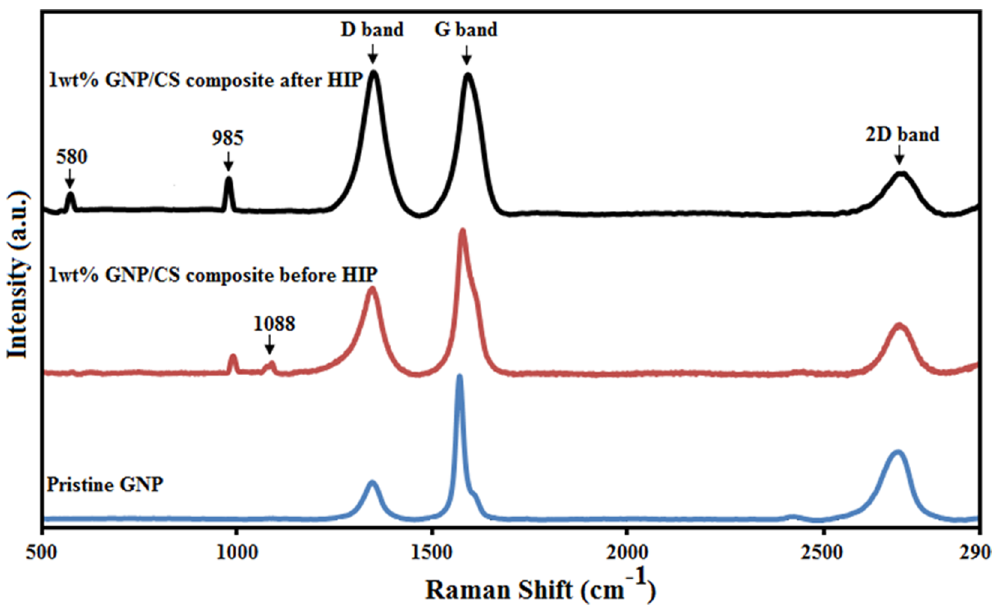
Figure 3. Raman spectra of pristine GNP, GNP/CS composite (1 wt.% GNP) before HIP and GNP/CS composite (1 wt.% GNP) after HIP.